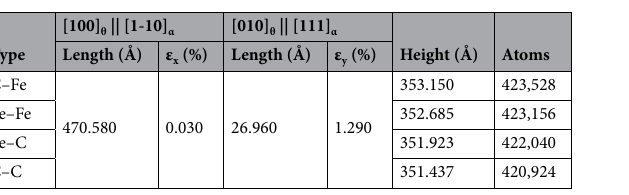
Table 2. Details of atomic